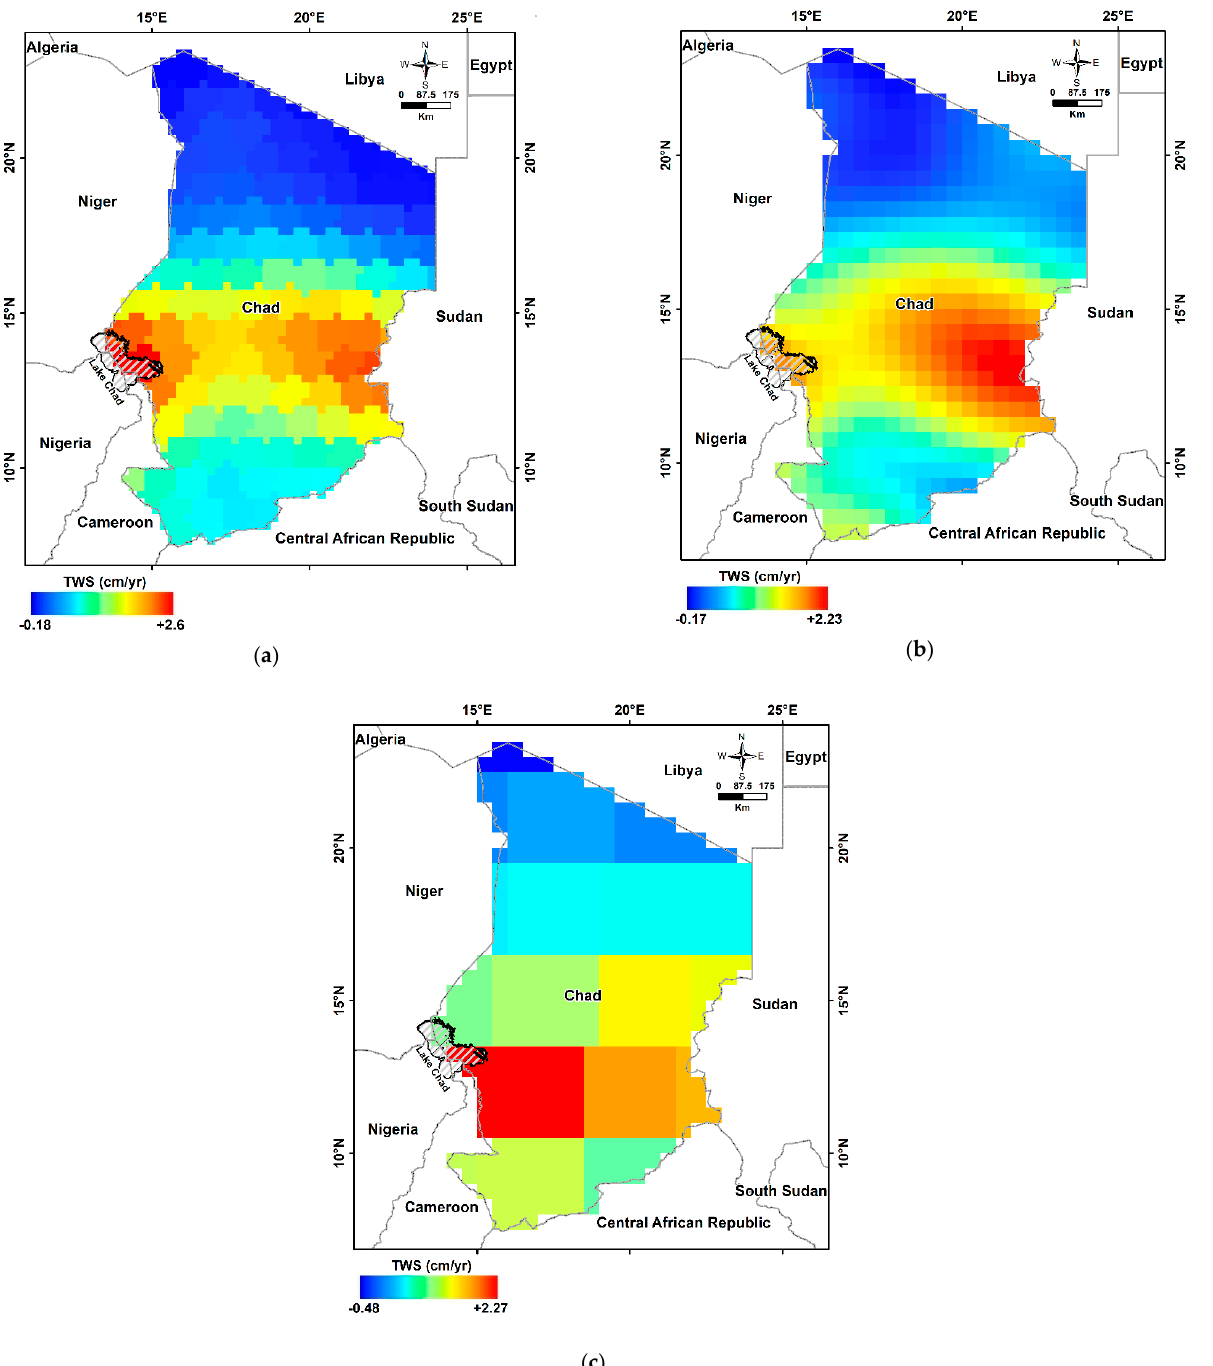
Figure 6. Spatiotemporal variation map of the Δ TWS trend during Period II from CSR ( a ), GSFC ( b ), and JPL ( c ) mascon products.